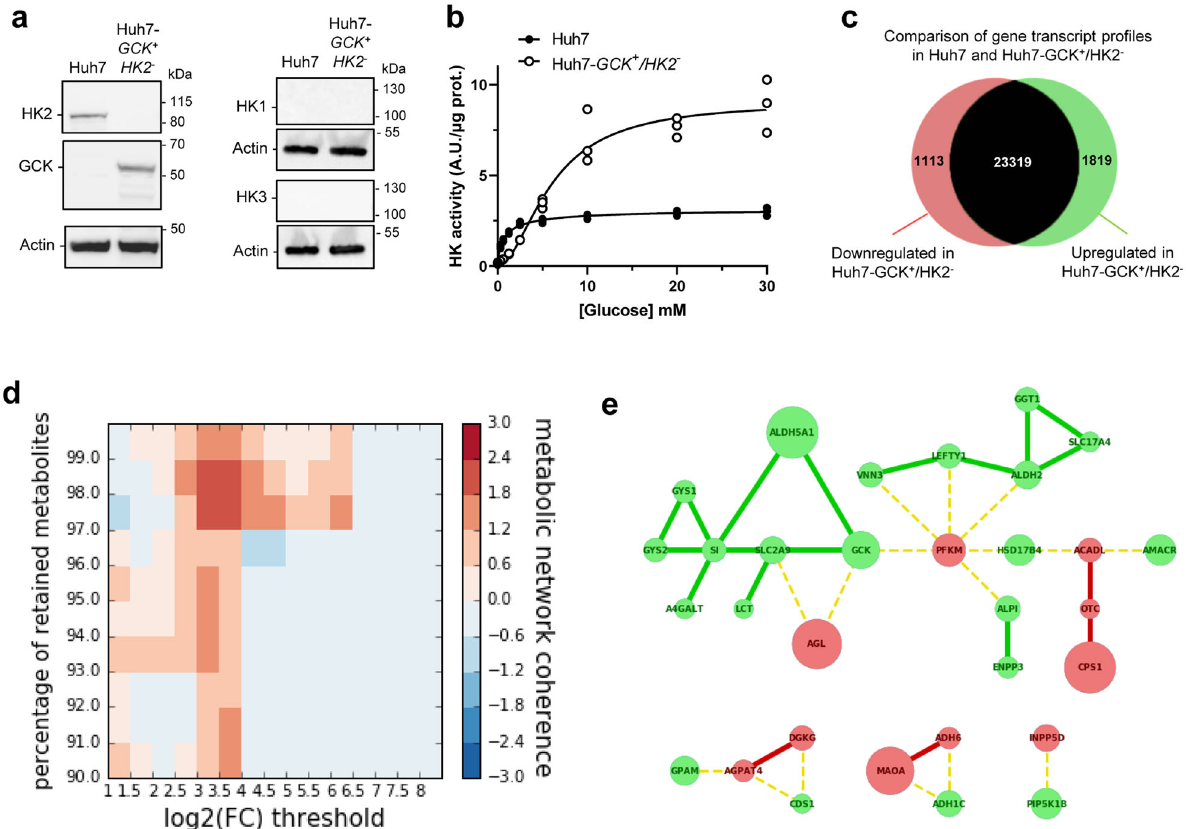
Fig. 2 Hexokinase isoenzyme switch in Huh7 cells induces extended modi fi cations of metabolic connections. a Western-blot analysis of HK1, HK2, HK3 and GCK expression in Huh7 and Huh7- GCK + /HK2 − . b Hexokinase activity in homogenates of Huh7 and Huh7- GCK + /HK2 − cells. Means ± SEM are presented ( n = 3). c Number of genes changing their expression pattern in Huh7 and Huh7- GCK + /HK2 − cells (see Supplementary Data 2 for details). d Heatmap showing clustering enrichment scores of the networks obtained when mapping differentially expressed genes to the human metabolic model Recon2. Clustering enrichment scores from the highest in red to the lowest in blue were calculated for different gene expression thresholds (Log 2 | FC | ) and percentages of retained currency metabolites. e Gene network corresponding to the maximal clustering enrichment score (Log 2 | FC | > 3; removed currency metabolites = 2%). The transcription of nodes in green was upregulated and those in red downregulated in Huh7- GCK + /HK2 − compared to Huh7 cells. Plain edges mark co-regulation between nodes and broken edges inverse regulation at the transcriptional level.